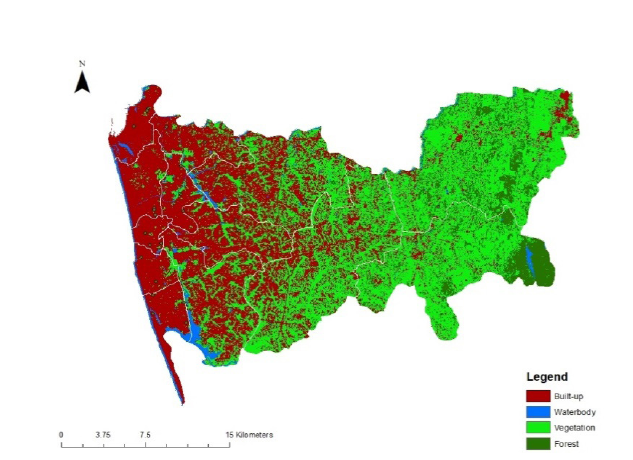
Figure 3: Vector map of LULC classes of Colombo district in